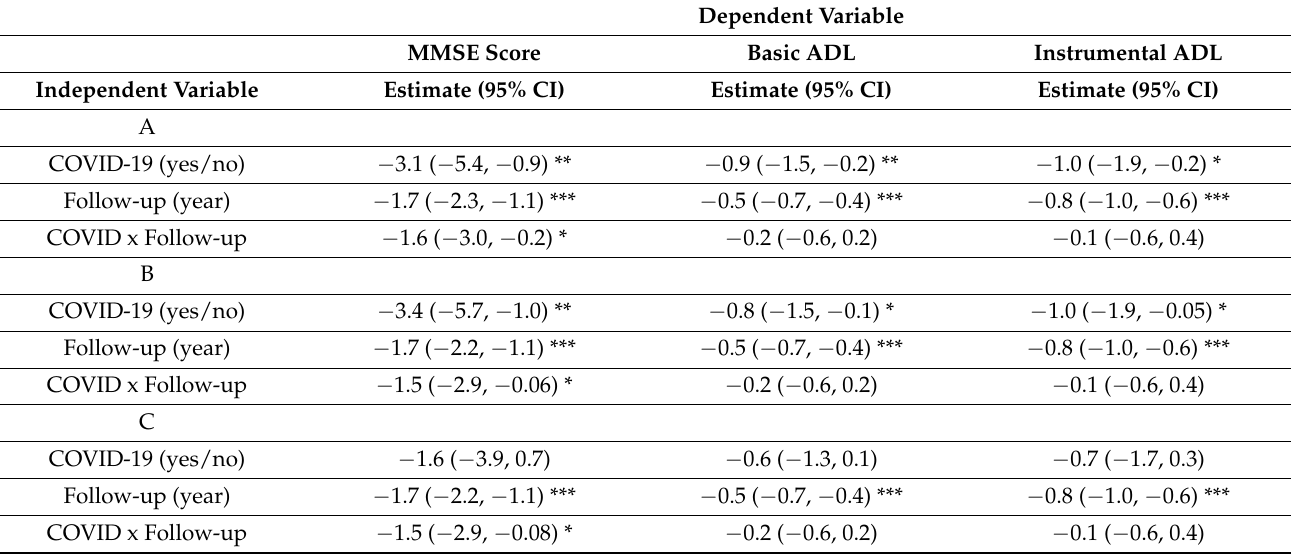
Table 4. Effect of COVID-19, follow-up time, and their interaction (COVID x follow-up time) on MMSE, basic ADL, and instrumental ADL changes by linear mixed effect model.